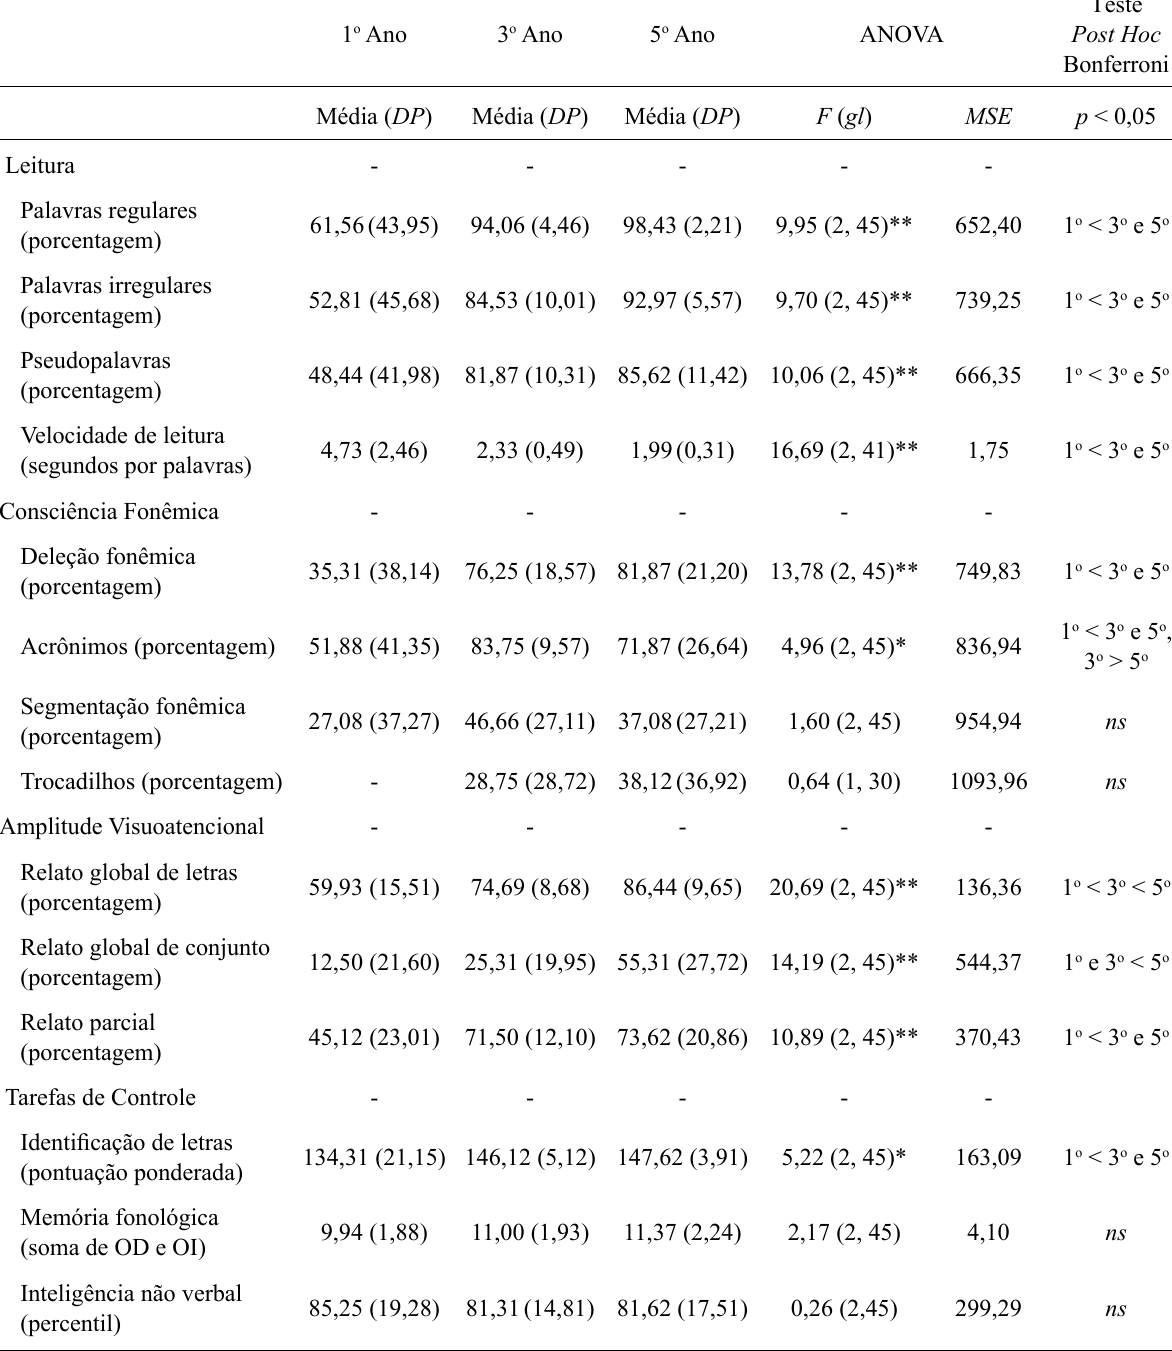
correlações signi fi cativas a p